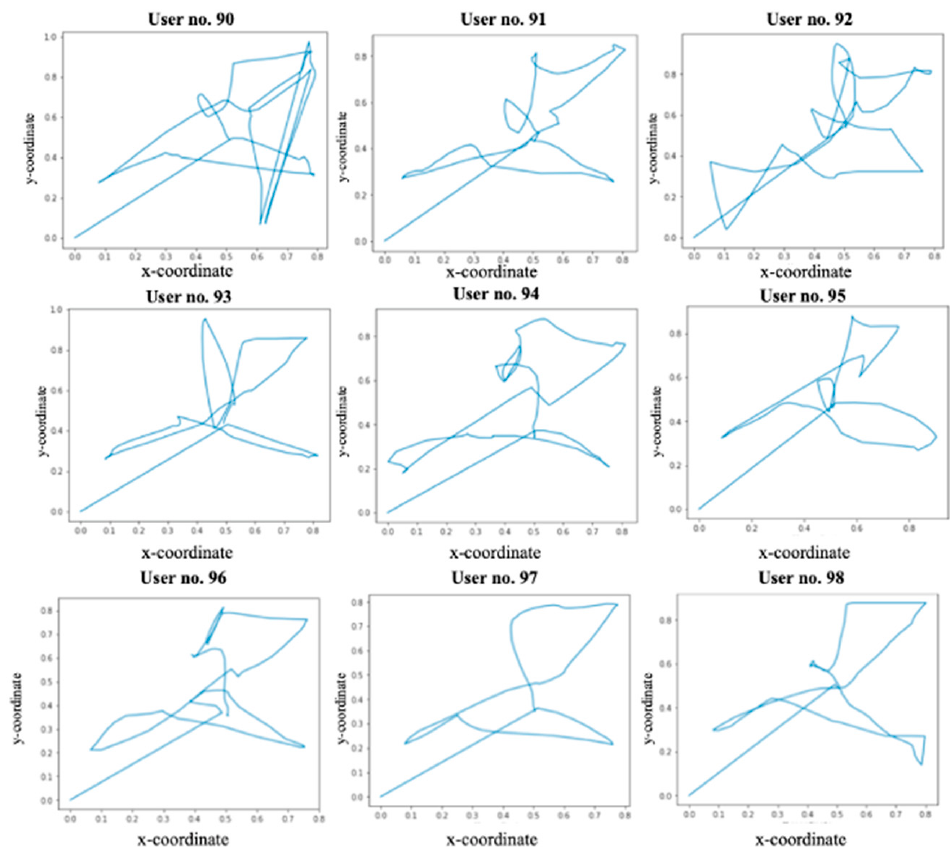
Figure 4. Visual representation of mouse cursor trajectory in the session with order number 3 for users 90 to 98.